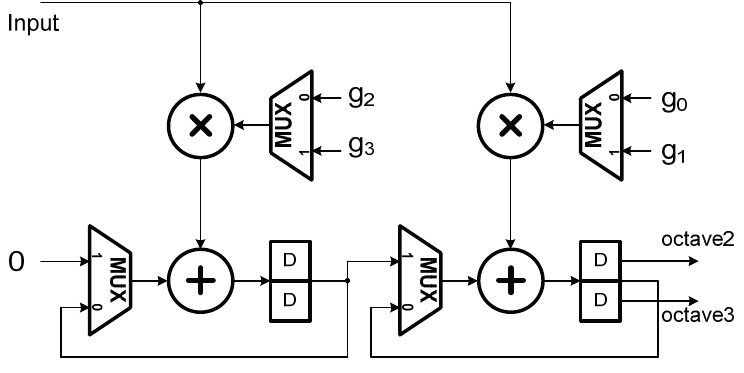
Figure 4. The second stage architecture of the 1D DWT as developed in